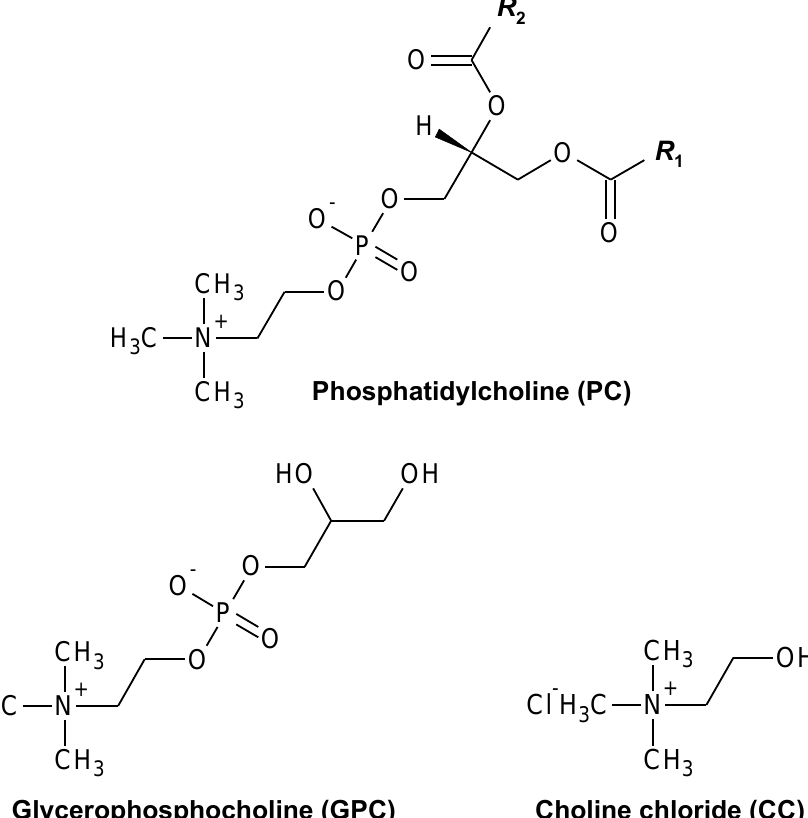
Figure 1. Chemical structures of phosphatidylcholine (PC), glycerophosphocholine (GPC), and choline chloride. “R” represents hydrocarbon groups.